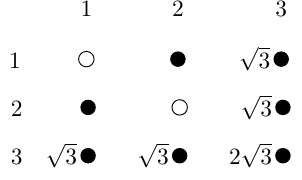
Figure 4 . Lattice for a system with n = 6 , u 0 = u 1 = 1 / 2 and u 2 = u 3 = 1 .